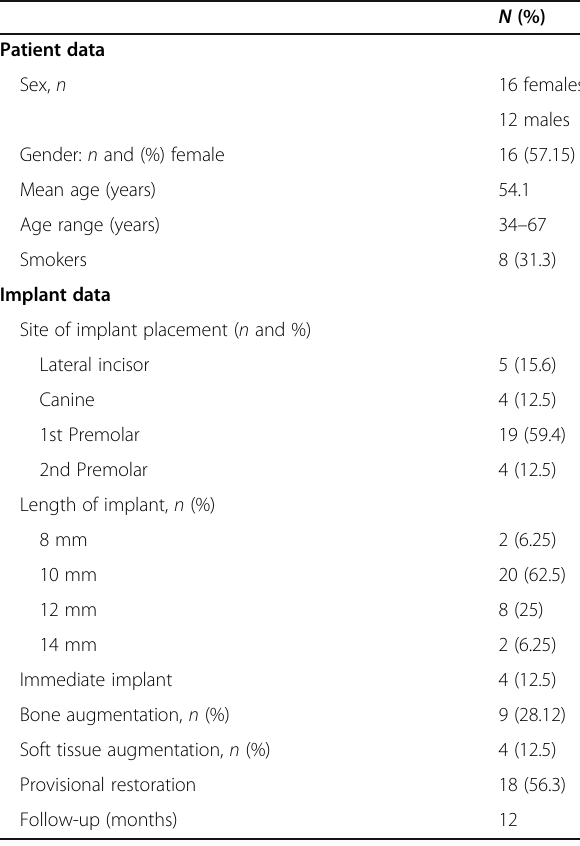
characteristics ( n = 32